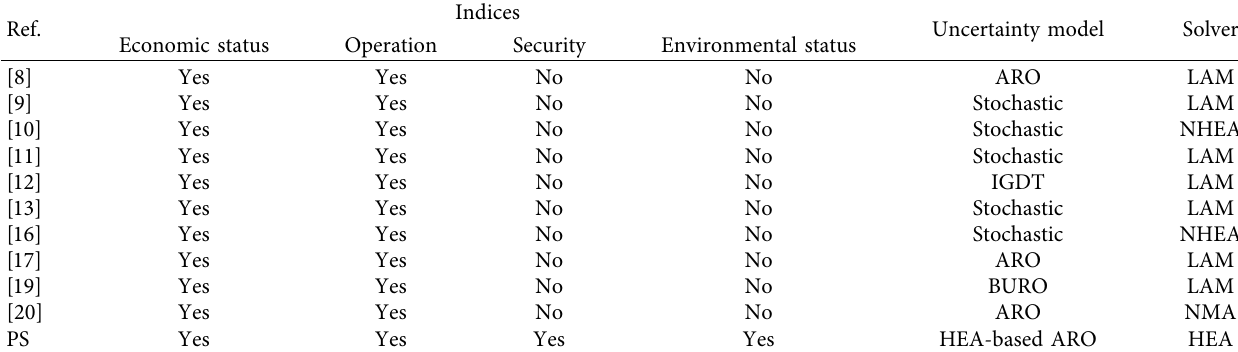
Table 1: Comparison of the proposed strategy with latest literature. Ref.